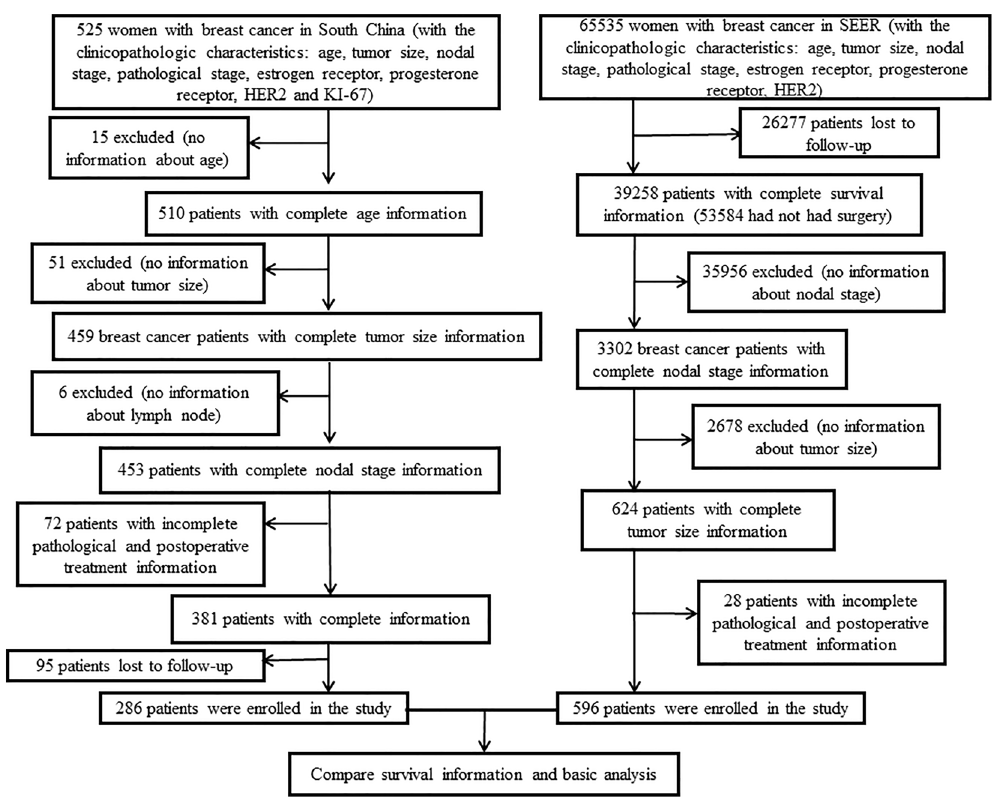
Figure 1. Flow chart for breast cancer patients in both Southern China and SEER